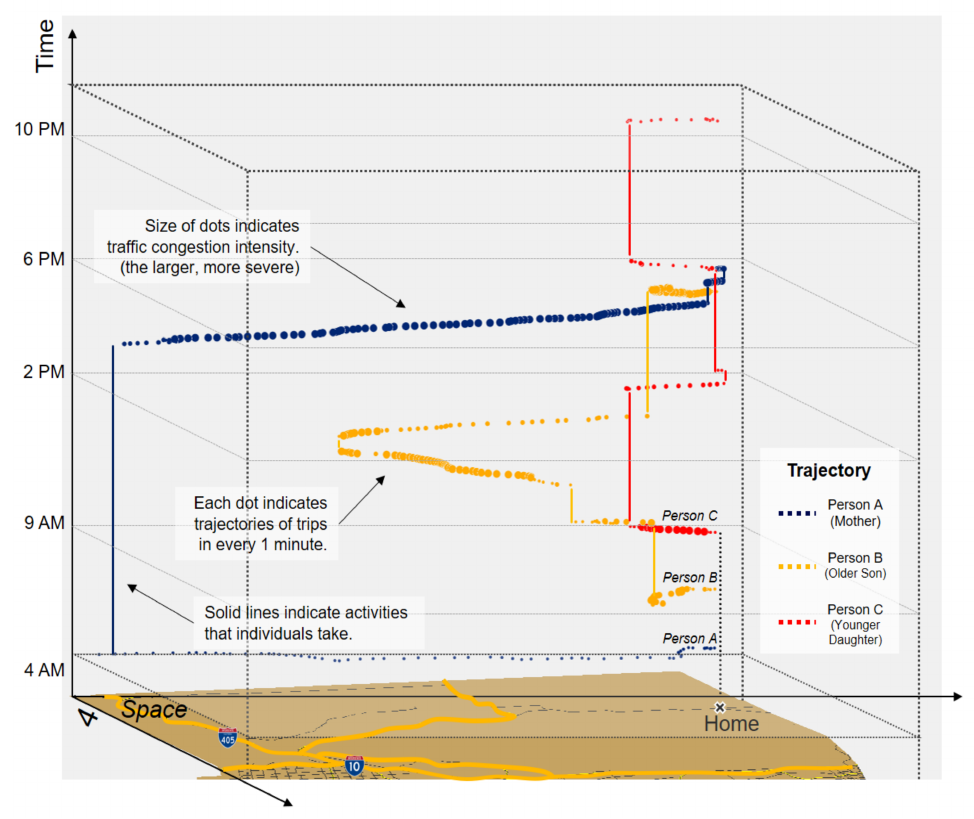
Figure 9. Space-time visualizations of traffic congestion exposures of three individuals from the same household (A: Mother, B: Older Son, C: Younger